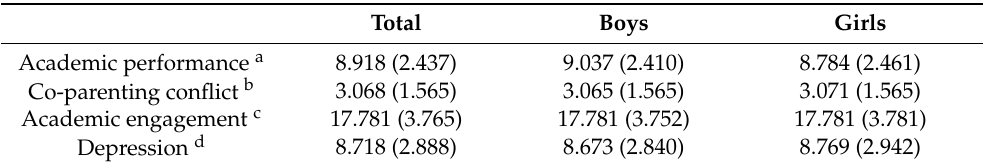
Table 1. Means and standard deviations of variables for the whole sample and both gender groups (standard deviations in parenthesis).